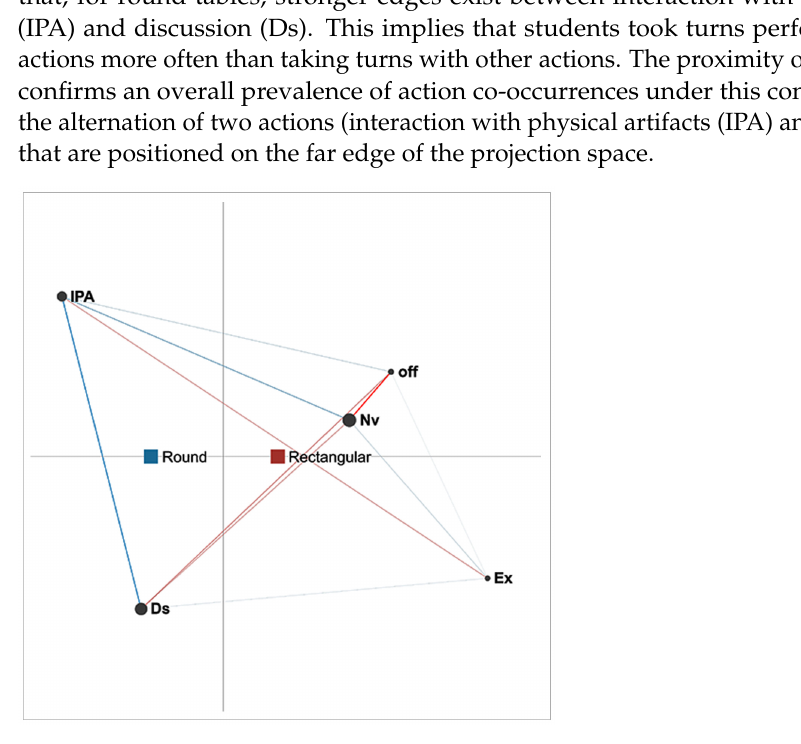
Figure 3. Difference network for triads under two conditions (round and rectangular tables).